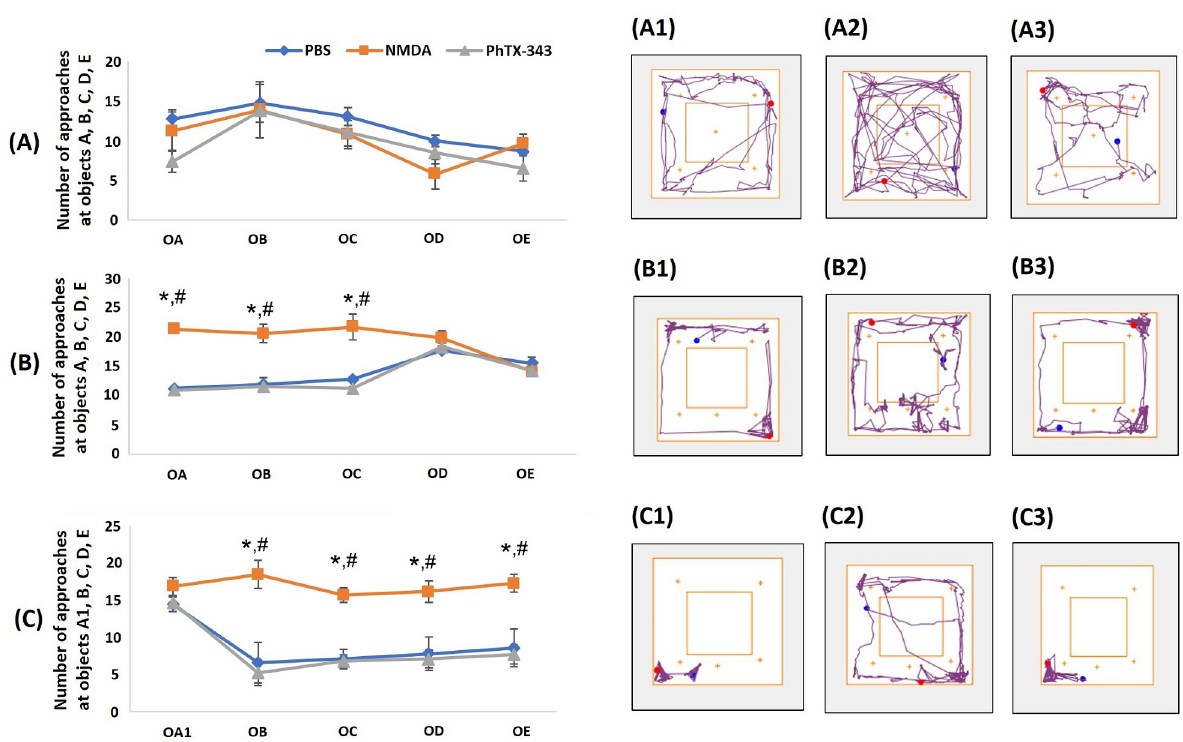
Fig 6. Effects of PhTX-343 on object recognition using open field arena in NMDA-induced rats. The line charts display the number of approaches by rats during: (A) familiarization phase, and examples of track plots for each group, (A1) PBS, (A2) NMDA, (A3) PhTX-343; (B) object displacement test, and examples of track plots for each group, (B1) PBS, (B2) NMDA, (B3) PhTX-343; (C) object replacement test, and examples of track plots for each group, (C1) PBS, (C2) NMDA, (C3) PhTX-343. Data were analyzed using Kruskal-Wallis test with Bonferroni correction: � p < 0.05 versus PBS; #p < 0.05 versus